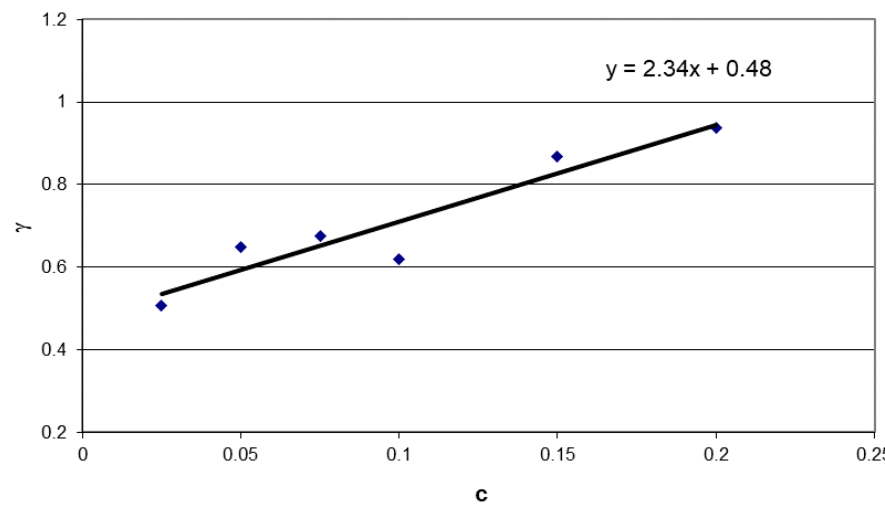
Figure 9. Plot of exponent γ on c for pitched-blade turbine.